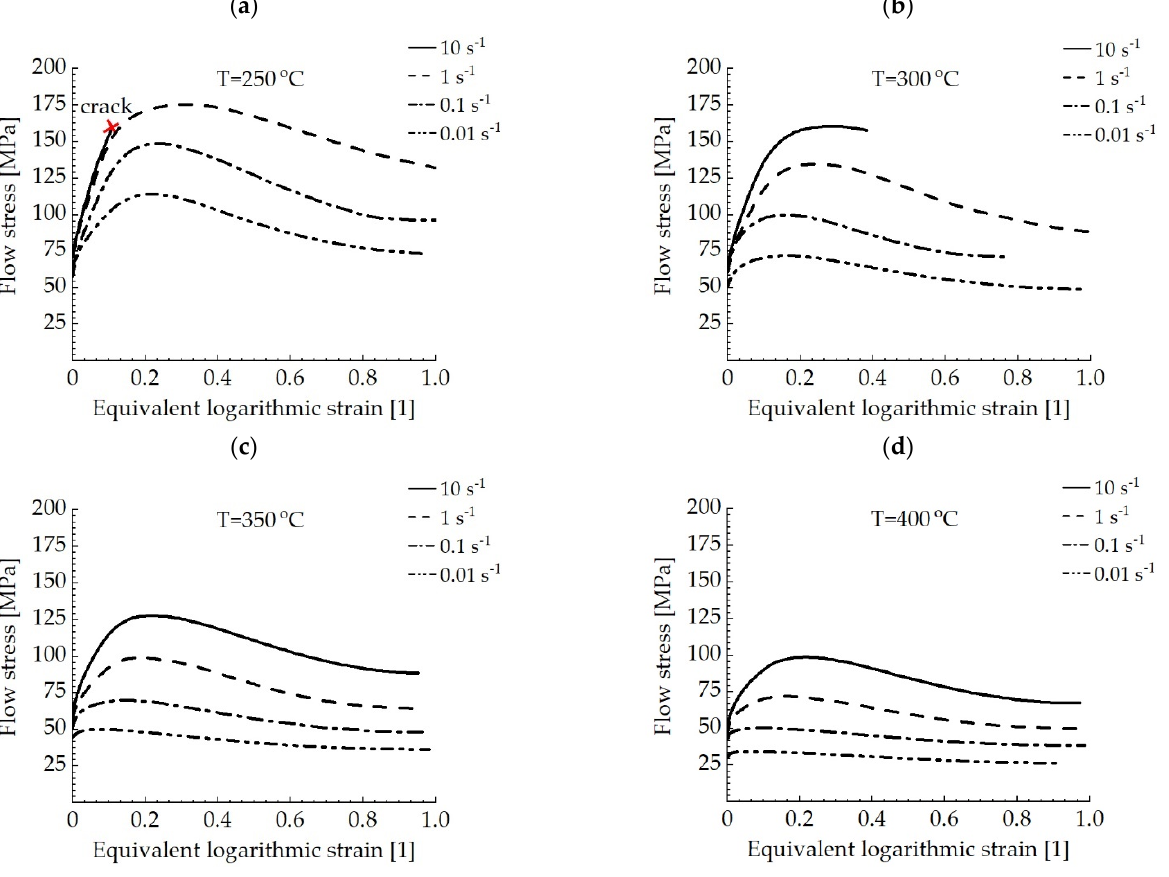
Figure 7. Flow curves of twin-roll cast and heat-treated magnesium alloy AZ31 at different forming speeds and temperatures: (( a ) 250 °C, ( b ) 300 °C, ( c ) 350 °C and ( d ) 400 °C).